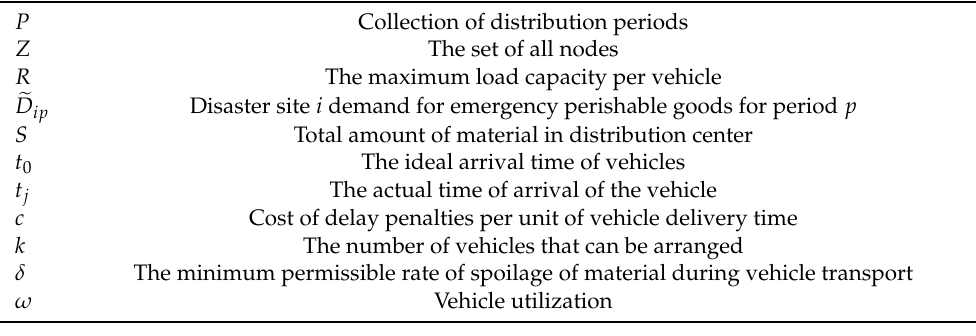
Table 1. The symbols and parameters used in the model.